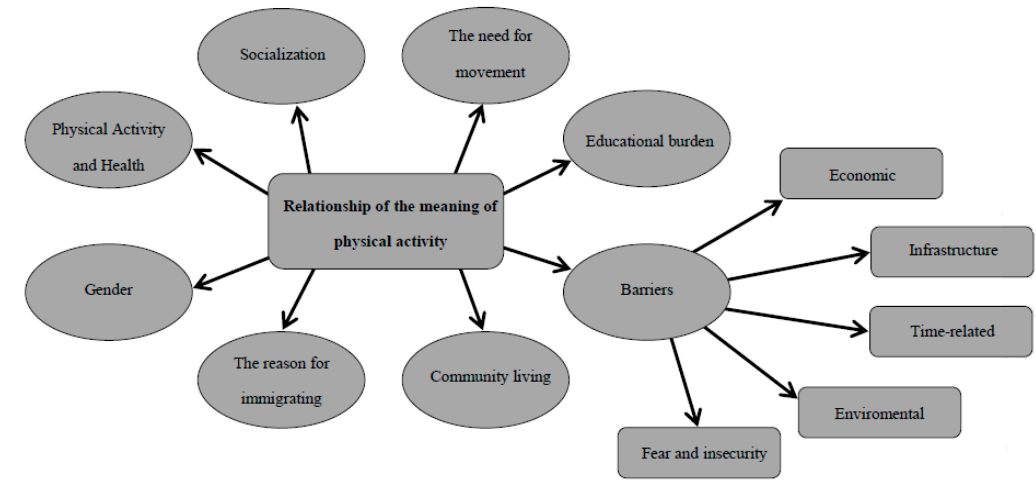
Figure 1. Conceptual map of results.